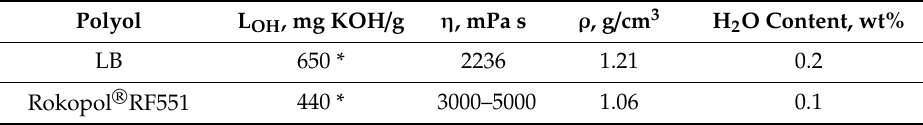
Figure 1. ( a ) proposed course of the main reaction occurring as a result of liquefaction of biomass; ( b ) chemical structure of Rokopol ® RF551. chemical structure of Rokopol®RF551. Table 1. Selected properties of polyols applied for the preparation of PUR-PIR Table 1. Selected properties of polyols applied for the preparation of PUR-PIR foams.